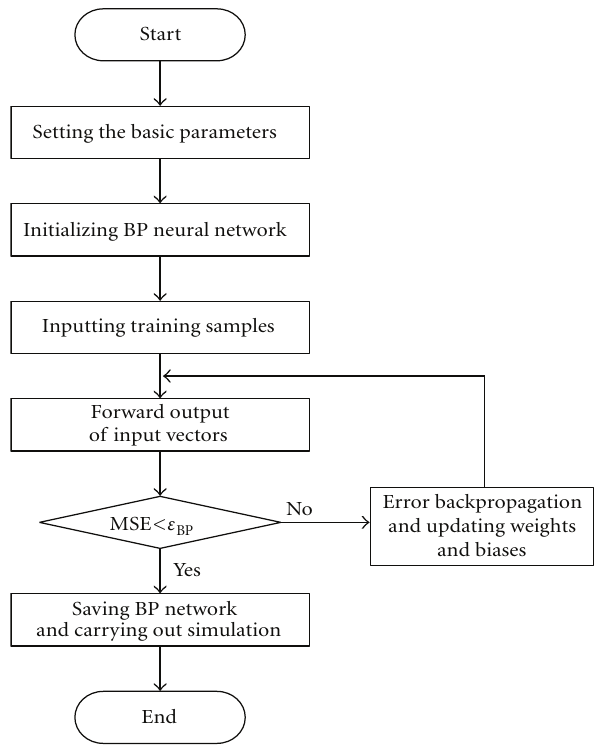
Figure 1: Computation flow chart of BP neural